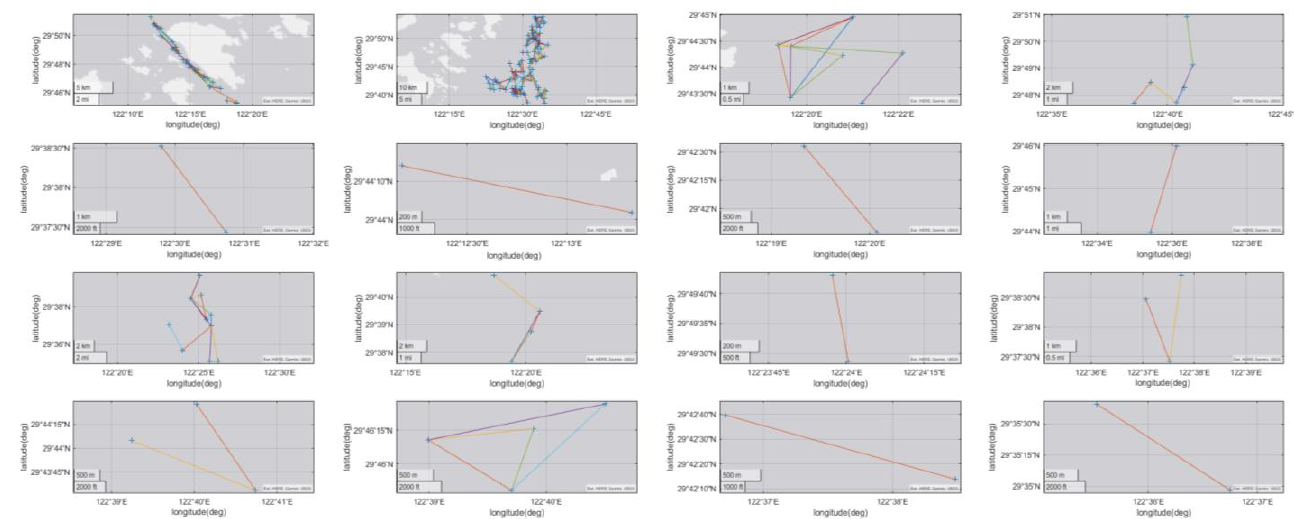
Figure 11. Ship encounter situation identification results.